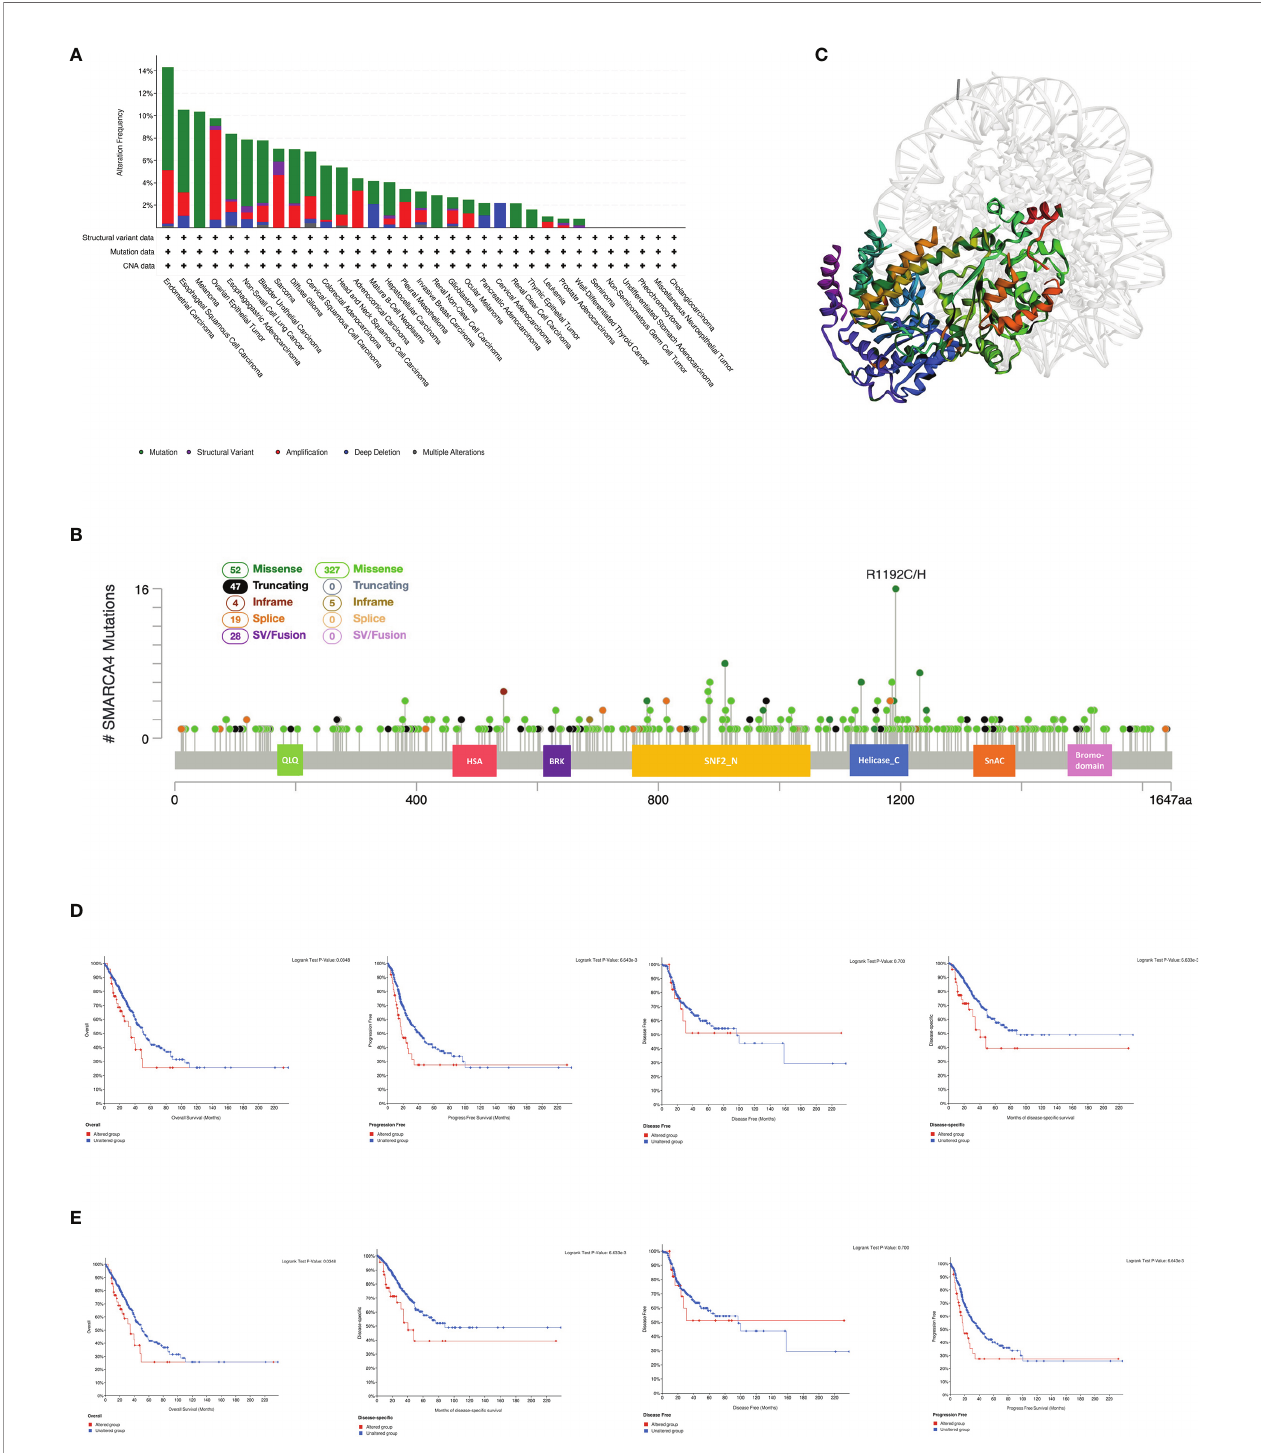
FIGURE 3 | Mutation feature of SMARCA4 in different tumors of TCGA. We analyzed the mutation features of SMARCA4 for the TCGA tumors using the cBioPortal tool. (A) The alteration frequency with mutation type is displayed. (B) Mutation sites are displayed. (C) The 3D structure of SMARCA4 was displayed. (D) The potential correlation between mutation status and overall, disease-speci fi c, disease-free, and progression-free survival of UCEC using the cBioPortal tool. (E) The potential correlation between mutation status and overall, disease-speci fi c, disease-free, and progression-free survival of LUAD using the cBioPortal